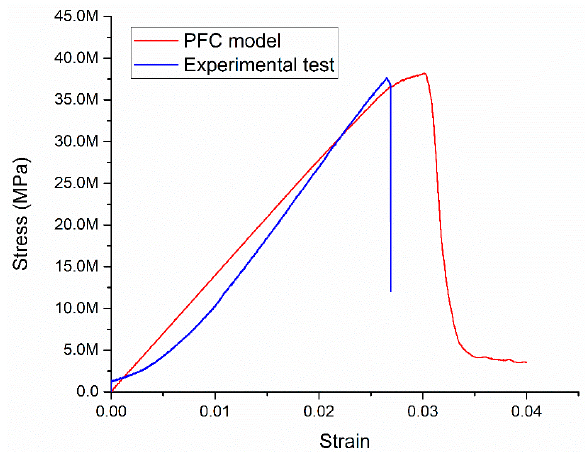
Figure 15. Comparison of stress-strain curves between numerical modeling and experimental tests under the confining stress of 0.25 MPa.